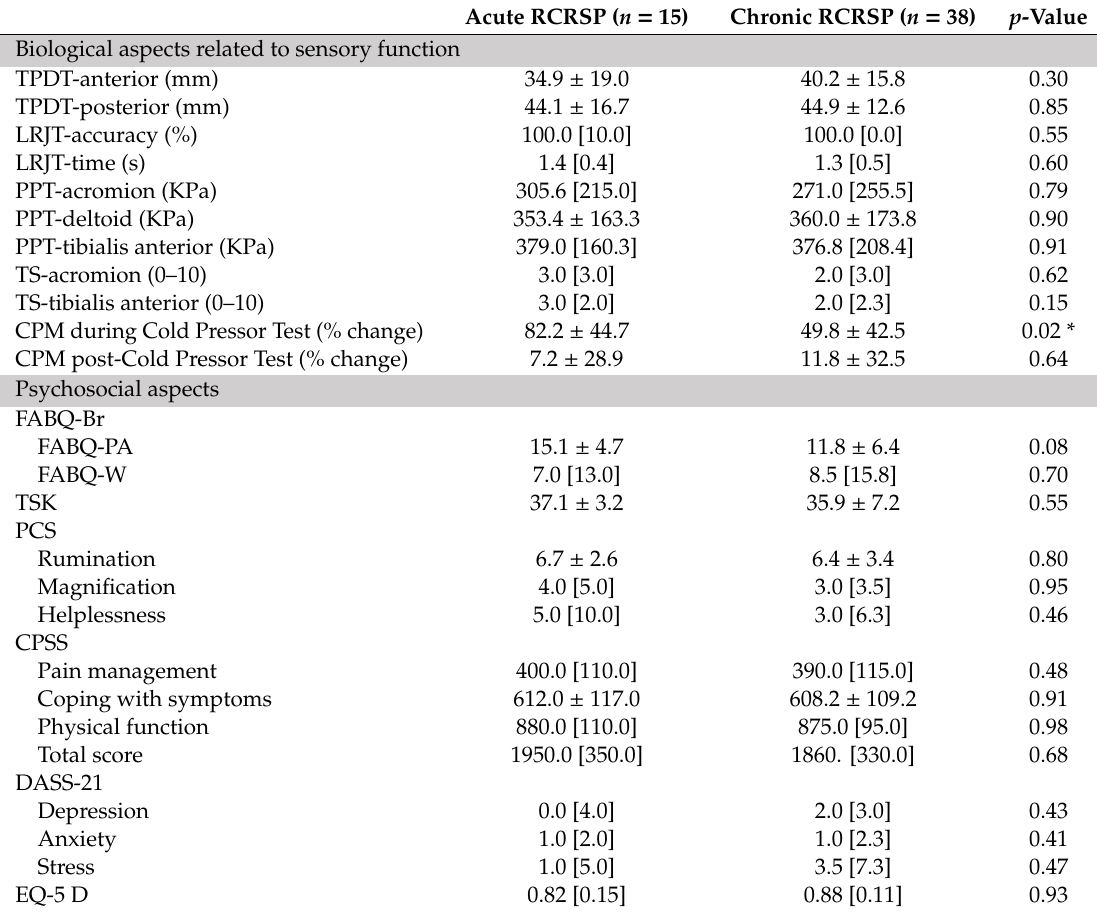
Table 2. Characteristics of the participants related to sensory and psychosocial